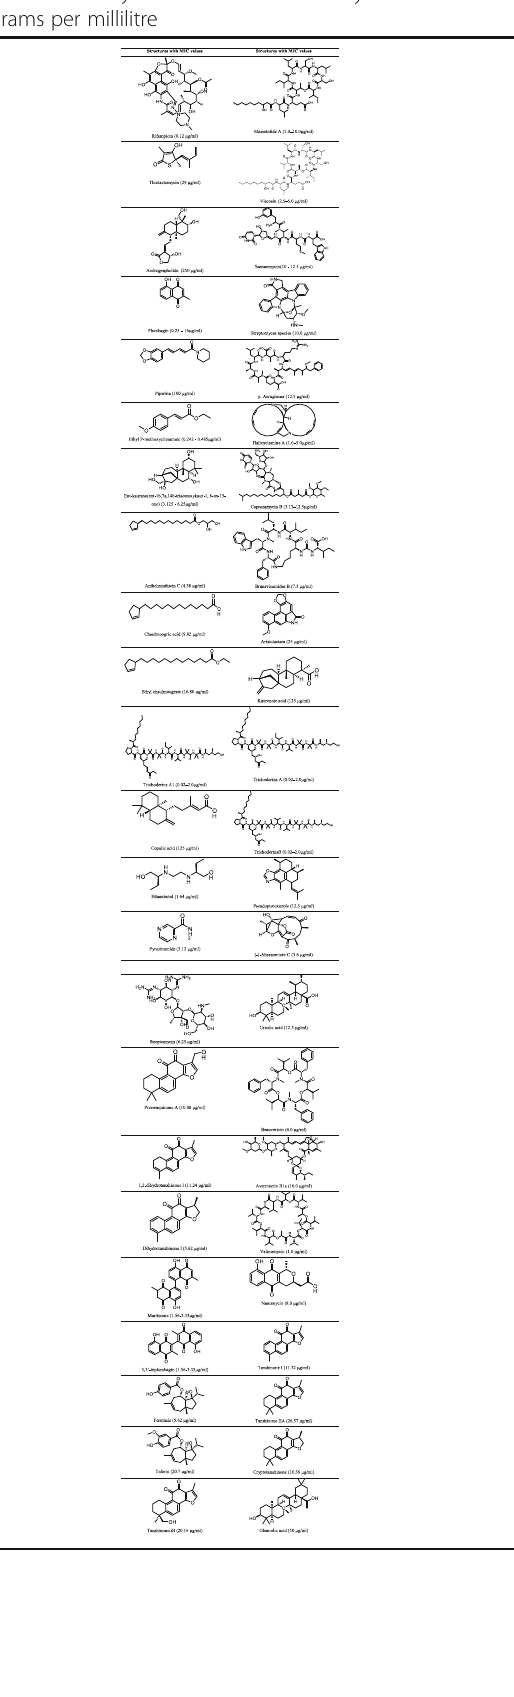
Table 7 Reported natural compounds with considerable antitubercular activity with minimum inhibitory concentration in micrograms per